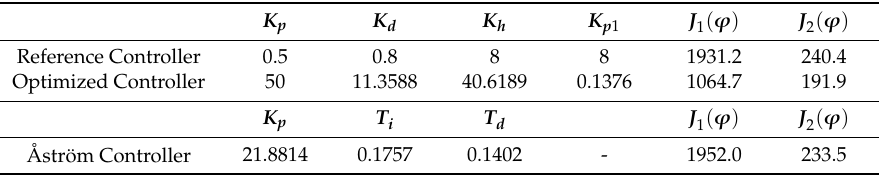
Table 2. Controllers’ gains and cost functions values.